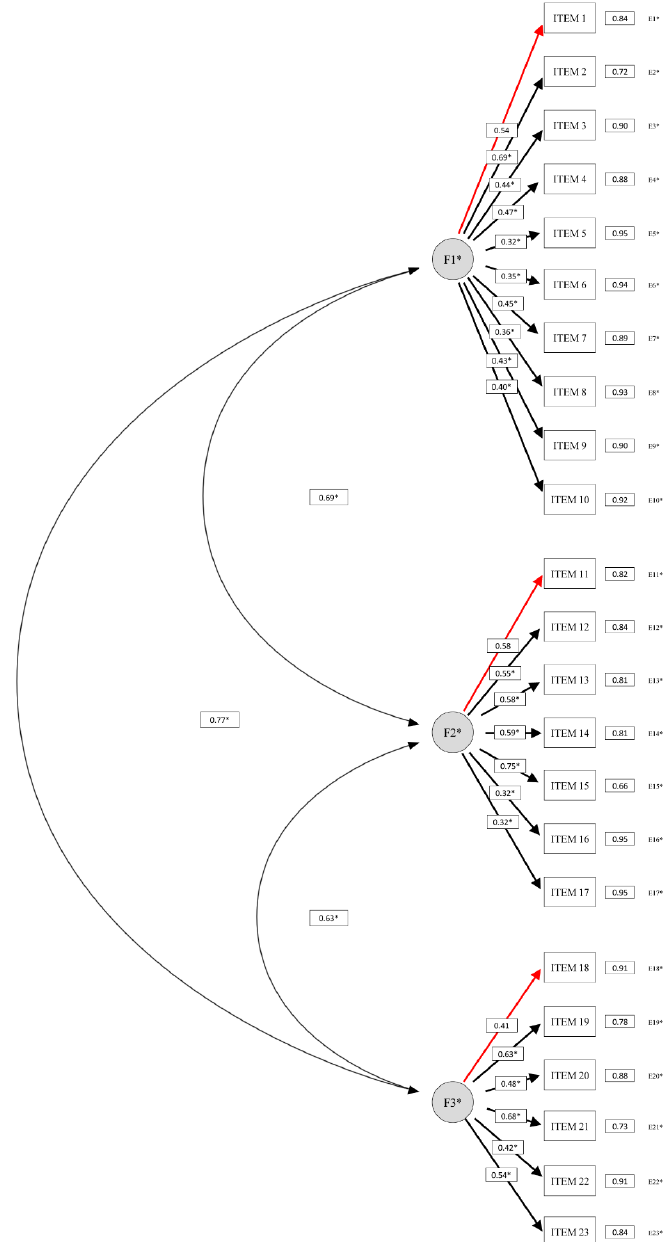
Figure 2. Confirmatory factor analysis of the Spanish DCDDaily-Q three-factor model with standardized estimates ( n = 276). Items 1, 11 and 18 fixed to 1 during estimation. * = p < 0.05; double-headed curved arrows—correlations between factors; F1—self-care; F2—fine motor; F3—gross motor; E—error.